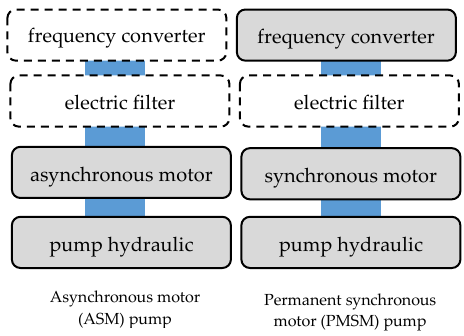
Figure 1. Mandatory (grey) and optional (white) components of submersible pump systems.